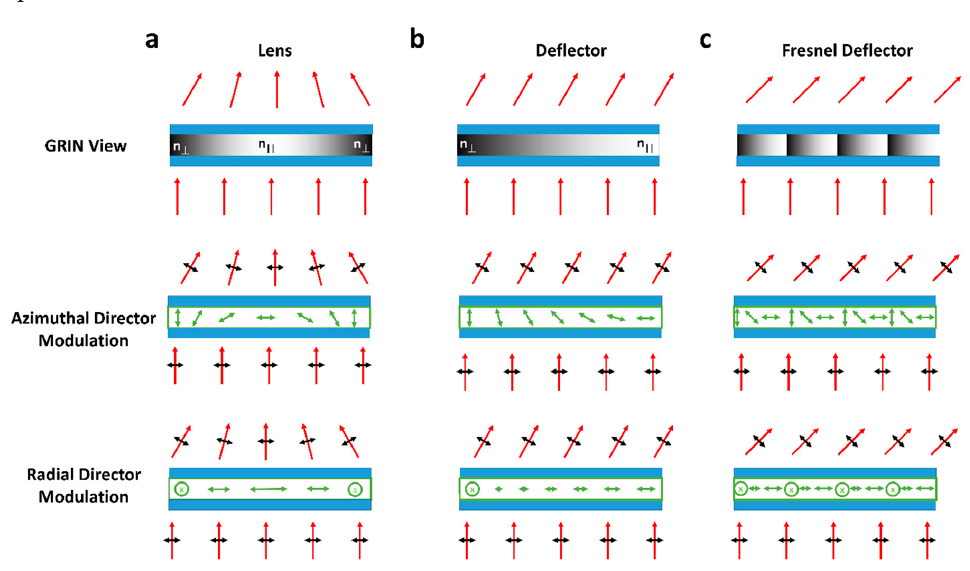
Figure 2. GRIN structures required for beam steering and lensing devices, with how they can be achieved for linearly polarised light by controlling either the radial or azimuthal orientation of n . ( a , b ) show a simple lens and deflector which will have relatively small gradient indexes. ( c ) Shows how ( b ) could be altered with a Fresnel structure to increase the gradient in refractive index for more significant optical